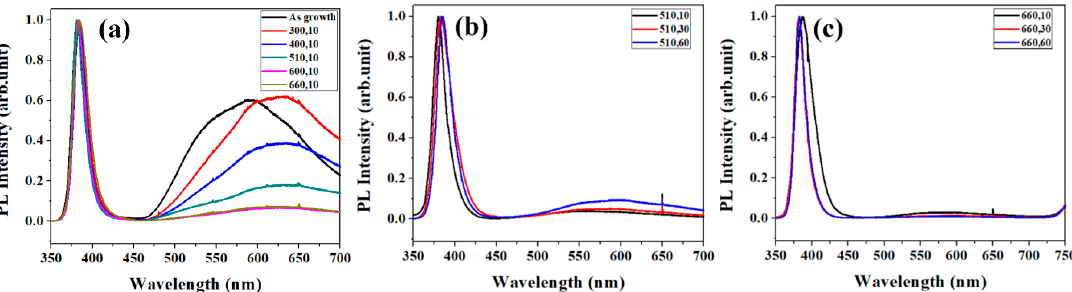
Figure 2. ( a ) PL for varied annealing temperature with the time of 10 s. ( b ) PL for the annealing temperature of 510 °C with varied time. ( c ) PL for the annealing temperature of 660 °C with varied